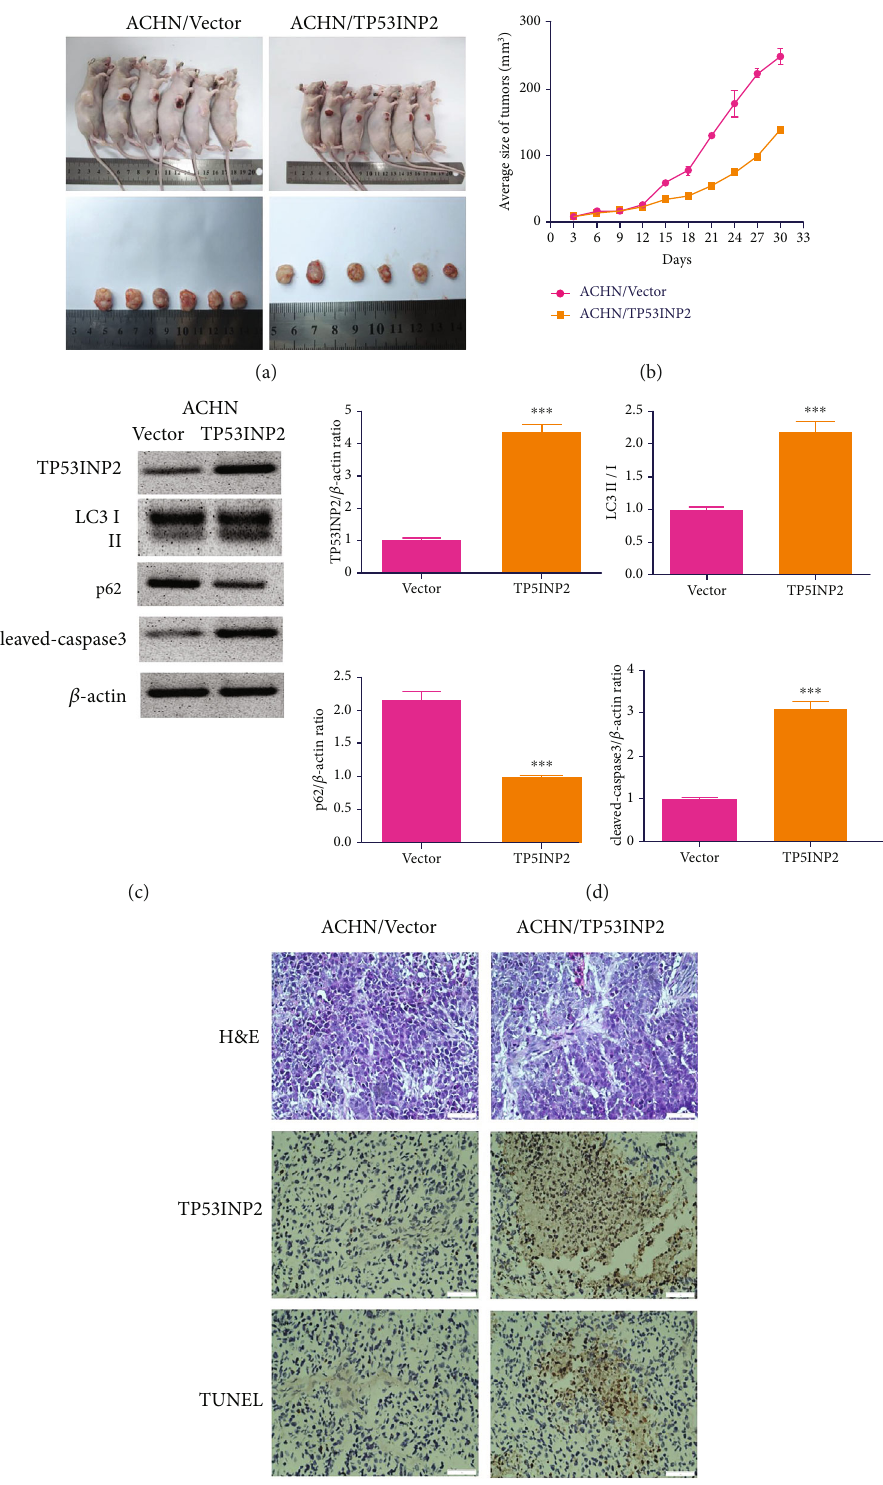
Figure 10: Overexpression of TP53INP2 inhibits tumor growth in mice. (a) and (b) Tumorous size was determined every three days. TP53INP2- or empty vector-transfected ACHN cells were injected into mice ( n = 6 ). (c) and (d) The levels of autophagy-related and proapoptotic protein in tumor tissue were determined by a way of western blot. (e) Representative H&E staining images of tumor tissue (400x). TP53INP2 expression was detected with immunohistochemistry (400x). TUNEL was used to detect apoptosis in tumor tissues (400x). ∗∗∗ P < 0 : 001